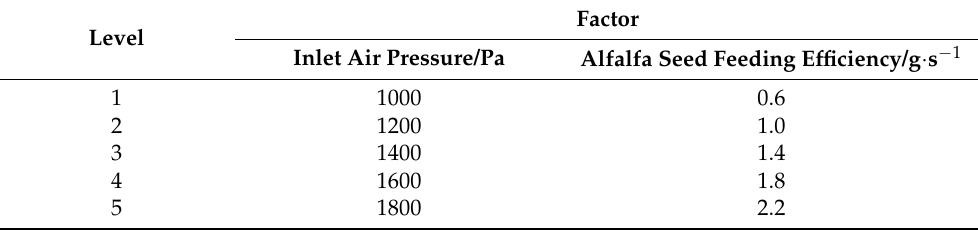
Table 4. Experimental factors and levels.